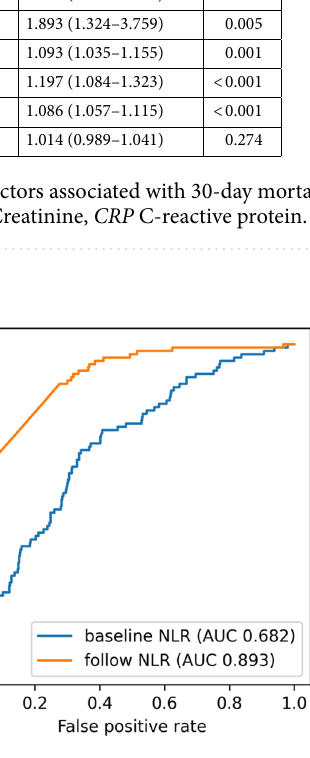
Figure 3. Receiver operating characteristics (ROC) for the prediction of mortality from NLR levels. ROC curves for mortality prediction were shown for baseline NLR (red) and follow-up NLR (blue) respectively. AUC, area under the